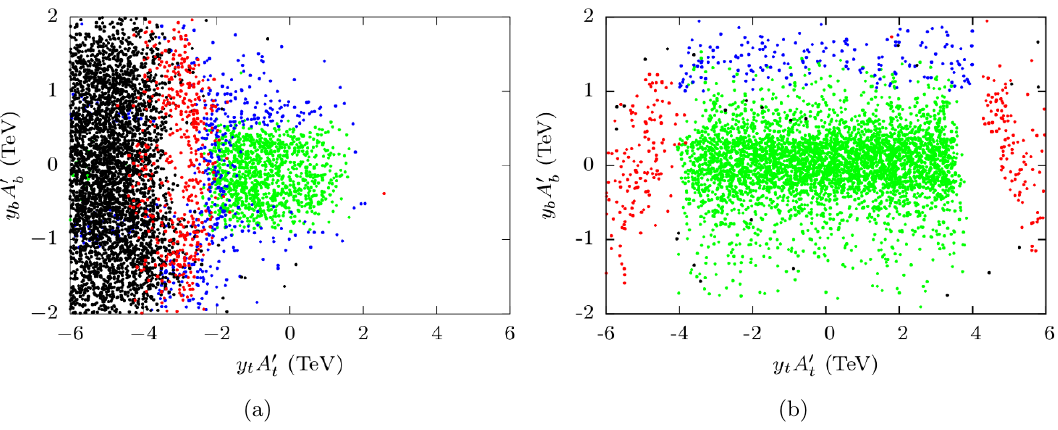
Figure 10 . Figures 10(a) and 10(b) are same as (cid:12)gure 9 with the limits on m h imposed. It is 1 evident that the region with y t A 0 > 2 TeV is excluded via limits on m h for low tan (cid:12) . t 1 constraint of eq. (3.6) on (cid:12)gure 9, results into (cid:12)gure 10. Figure 10(a) shows that a large region of parameter space associated with y A 0 > 2 TeV is excluded via the limits on m . t h 1 t As expected, A 0 plays a signi(cid:12)cant role in the radiative corrections to m for low tan (cid:12) . h 1 t For large tan (cid:12) , as shown in (cid:12)gure 10(b), A 0 is also important in regard to vacuum stability b but the radiative corrections to m keeps it well within the range of eq. (3.6). This is h 1 consistent with the results obtained from (cid:12)gure